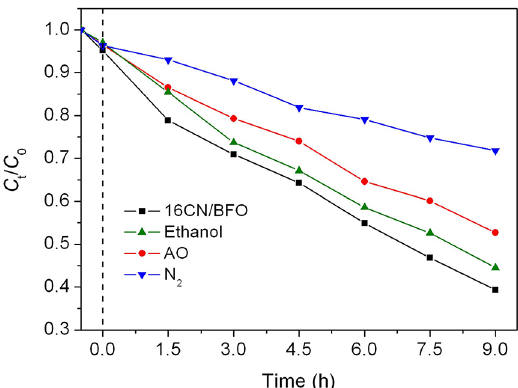
, ammonium oxalate (AO) and ethanol on Figure 8. Effect of N 2 the photocatalytic degradation of MB over 16CN/BFO sample. Initial conditions: C (MB) = 5 mg/L, C (catalysts) = 0.5 g/L, C (AO) flow rate = 0.1 =2×10 -3 mol/L, C (ethanol) =10 % by volume, N 2 L/min, T = ~ 20ºC.